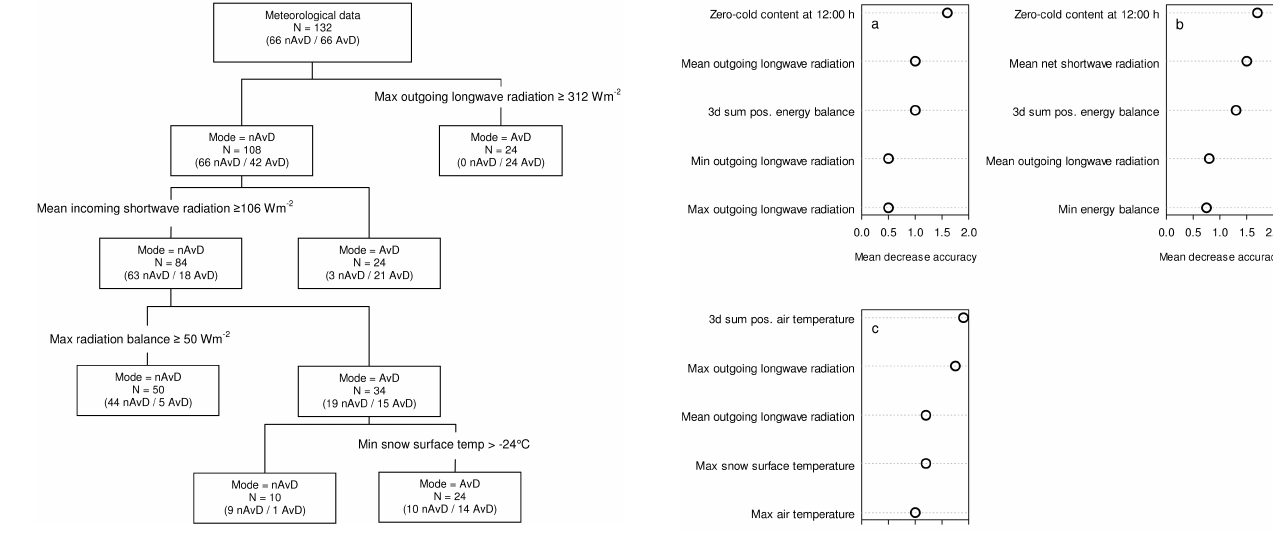
Fig. 2. Classification tree to discriminate between avalanche (AAI > 2) and non-avalanche days. Input data were all meteorolog- ical variables taken from WFJ, if U -test was significant. Forecast scores of the tree: probability of detection (POD) = 0.89; probabil- ity of non-events (PON) = 0.8; true skill score (HK) = 0.69.